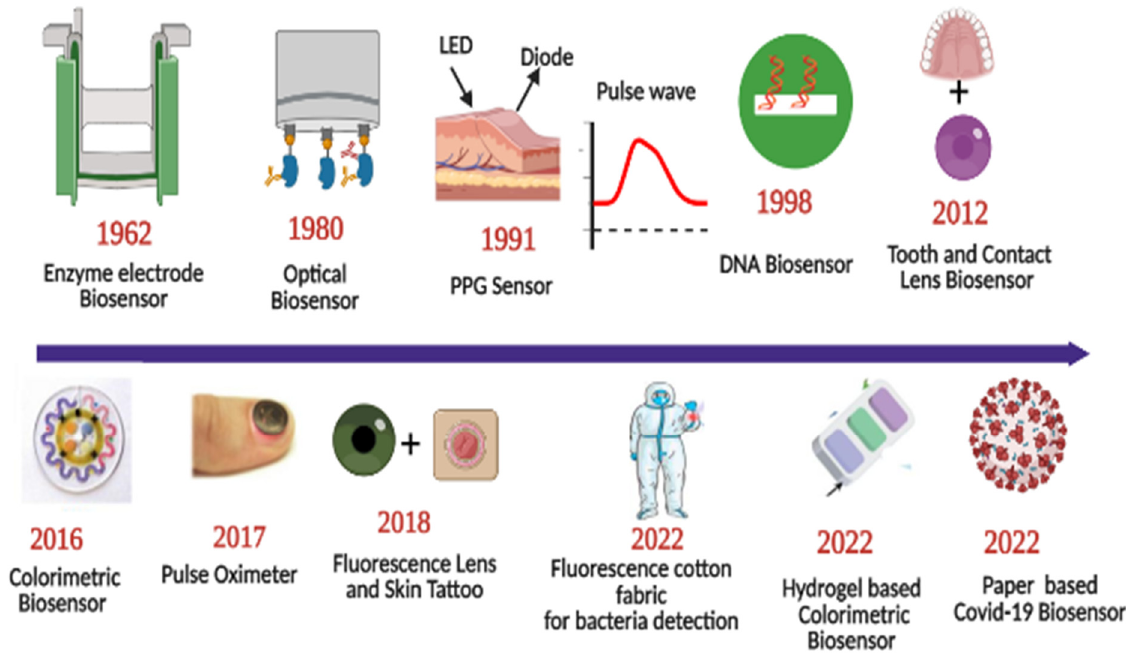
Figure 1. Roadmap of progress of wearable optical sensors. Reprinted with permission from Science